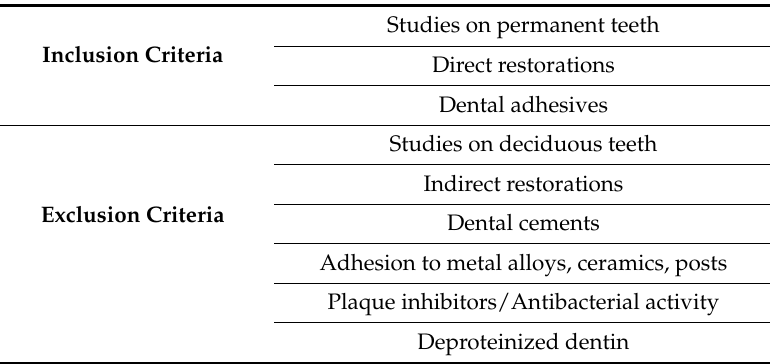
Table 3. Inclusion and exclusion